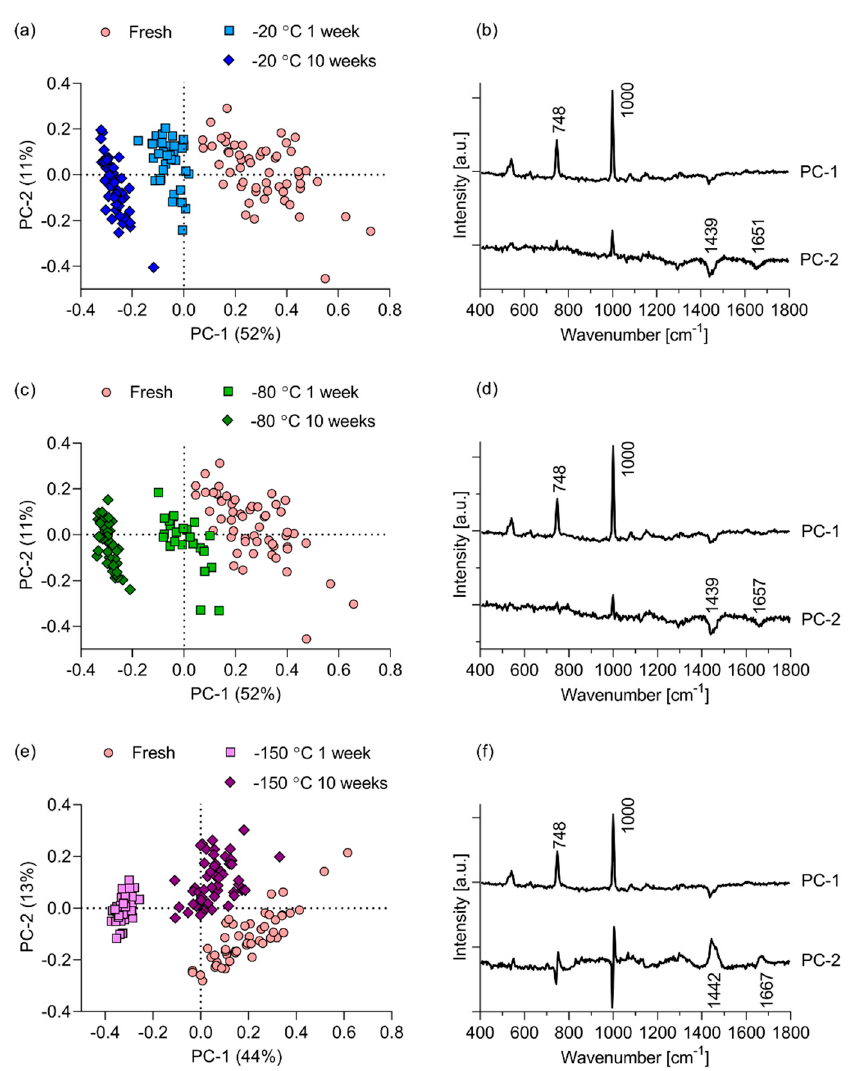
Figure 6. Score and loading plots for the first 2 components obtained from the PCA of resorcinol-exposed fresh EpiSkin™ RHE vs. the RHE stored for 1 and 10 weeks at ( a , b ) − 20, ( c , d ) − 80, and ( e , f ) − 150 °C.